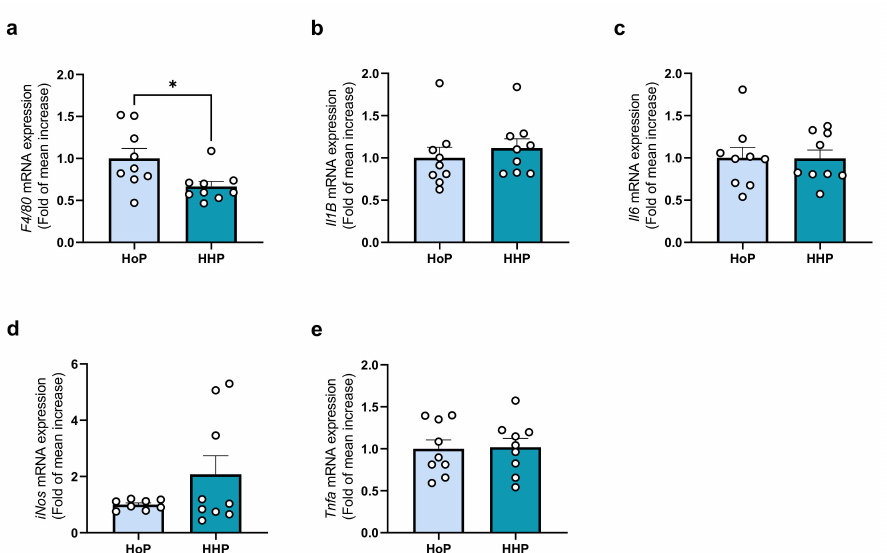
Figure 4. Inflammatory markers in the ileum following a 7 days gavage of mice with HoP- or HHP- DM. ( a ) F4/80 (F4/80), ( b ) Il1 β (IL1 β ), ( c ) Il6 (IL6), ( d ) iNos (iNOS), ( e ) Tnf α (TNF α ). n = 9 in each group, * p < 0.05.